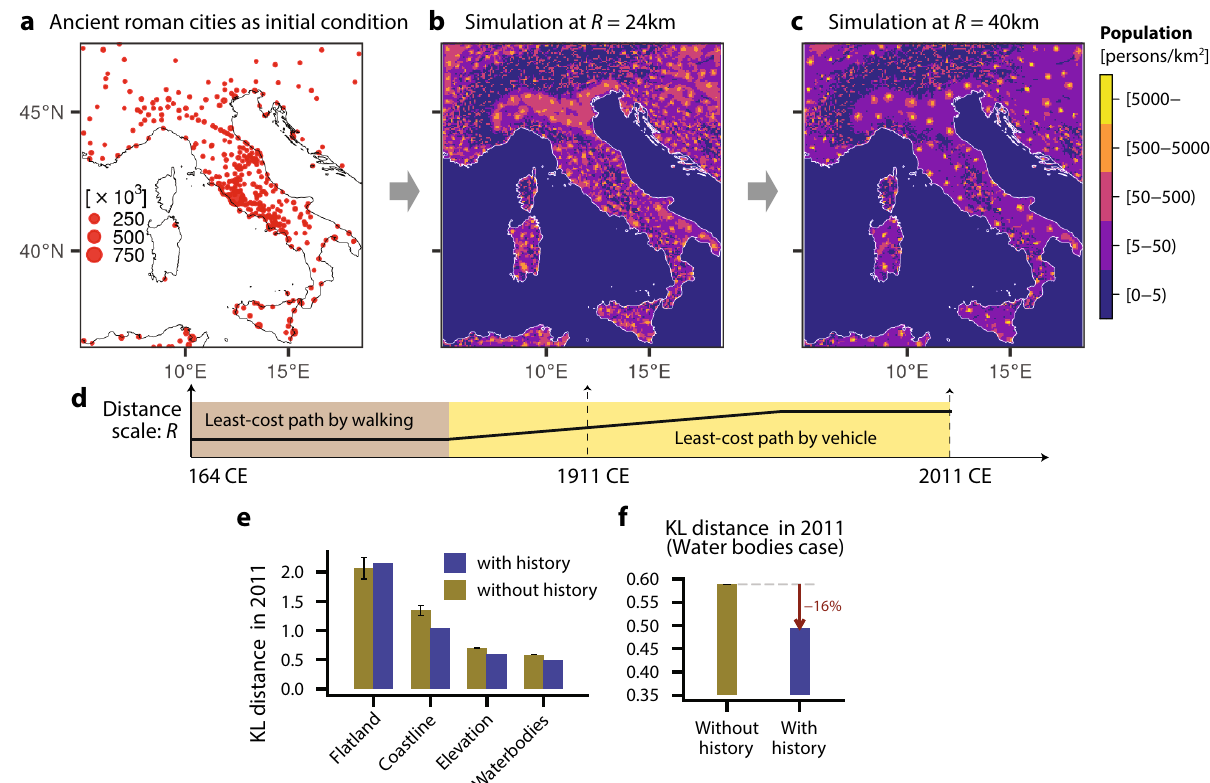
Figure 5. Historical dependency of the simulation on the past population distribution in Italy. ( a–d ) The initial state ( a ) is given by estimates of population distribution in ancient Roman cities. Starting from this initial state, the intermediate state of the simulation at R = 24 km ( b ) and the final state with R = 40 km ( c ) are depicted, as the distance scale, R , is increased ramped up from 8 to 40 km during the simulation ( d ). ( e,f ) Improvement in the KL distance from the 2011 census data at the Provincia -level by the inclusion of historical development is shown for all scenarios ( e ), and zoomed-in for the final Water Bodies scenario ( f